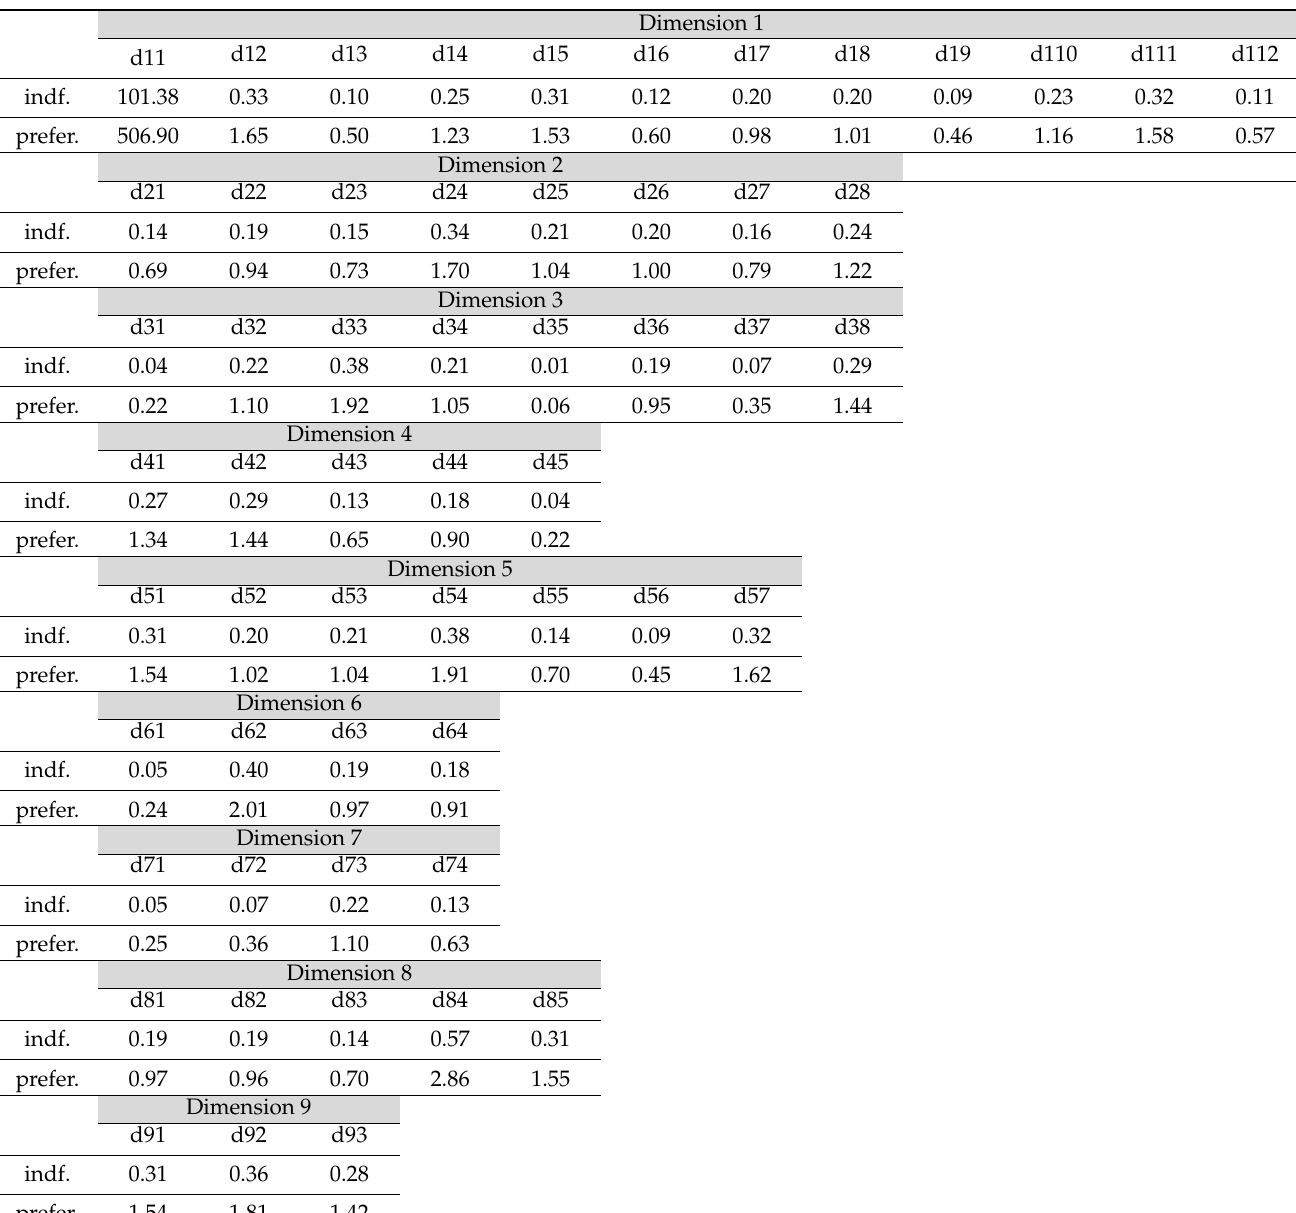
Table 8. The indifference and preference thresholds for each one of the indicators of the 9 dimensions. Dimension